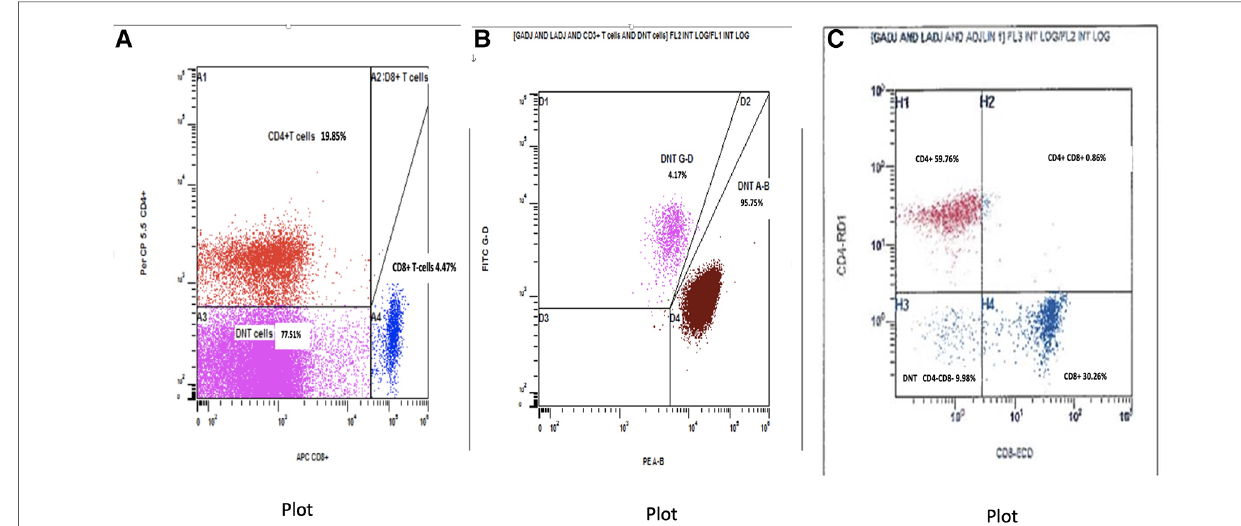
FIGURE 2 ( A ) Baseline fl ow cytometry plot gated on CD3+ T-cells to assess the expression of CD4 and CD8. Lower left quadrant indicates DNTs (including αβ and γδ T-cells). ( B ) Baseline fl ow cytometry plot gated on DNTs showing predominant αβ vs. γδ T-cell receptor expression. ( C ) Post-treatment fl ow cytometry plot gated on CD3+ T-cells to assess CD4 and CD8 expression. The huge population of DNT noted pretreatment in the lower left quadrant has almost completely disappeared. DNT, double-negative CD3+